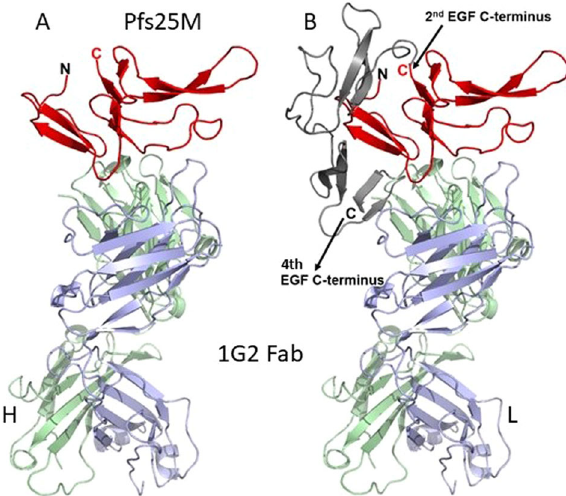
Fig. 4 Structure of Pfs25M in complex with the 1G2 Fab. In ( A ), is the structure of the fi rst two epidermal growth factors (EGF) like domains of Pfs25M (red). The 1G2 Fab binds to the two EGF-like domains with its heavy chain (H, green) making contacts with residues of EGF-like domain 1 and its light chain (L, blue) making contacts with EGF-like domain 2. In ( B ), similar to ( A ), but with domains 3 and 4 (gray) from the Pfs25 structure from PDB code: 6PHB 15 overlaid on the fi rst two EGF-like domains (red) from the 1G2 structure. EGF-like domains 3 and 4 (gray) are nestled with domains 1 and 2 to form a roughly triangular shape. The C-termini of EGF domains 2 and 4 are